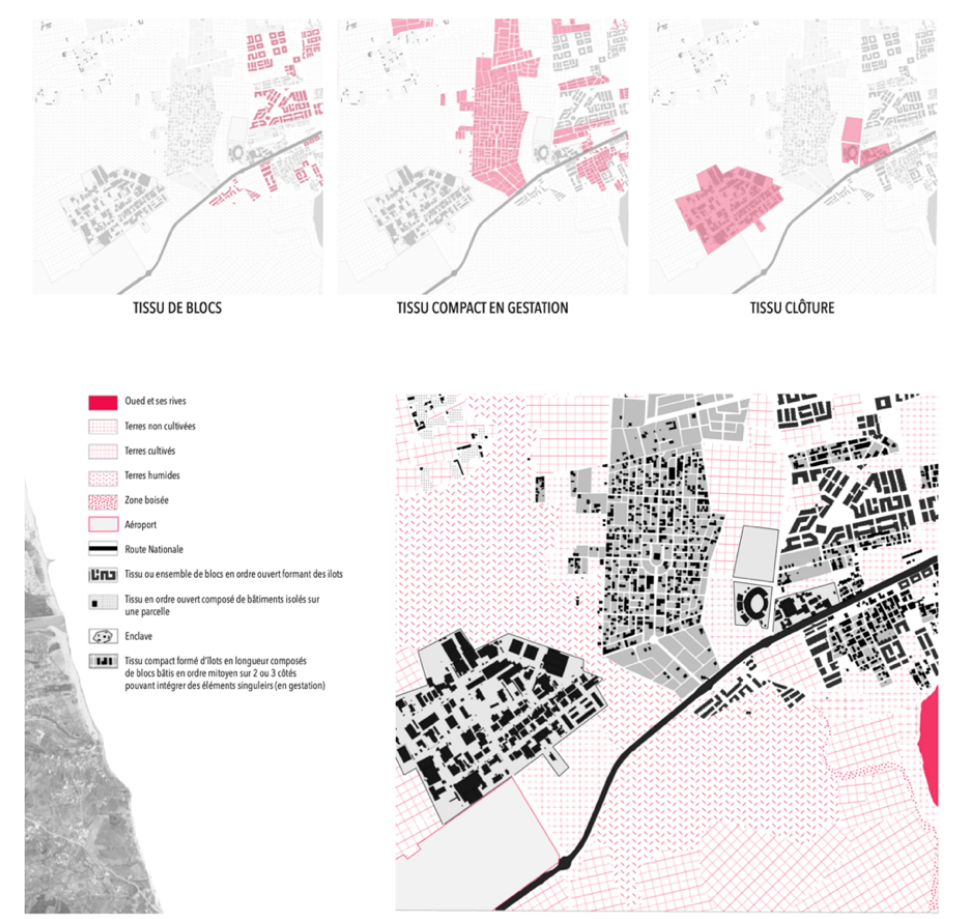
Figure 3. Grand Tetouan region: Synthetic map of the urban materials, close-up of the Oum-Kaltoum area with correspond- ing legend. Source: Terrains d’Architecture, Master in Architecture Design Studio